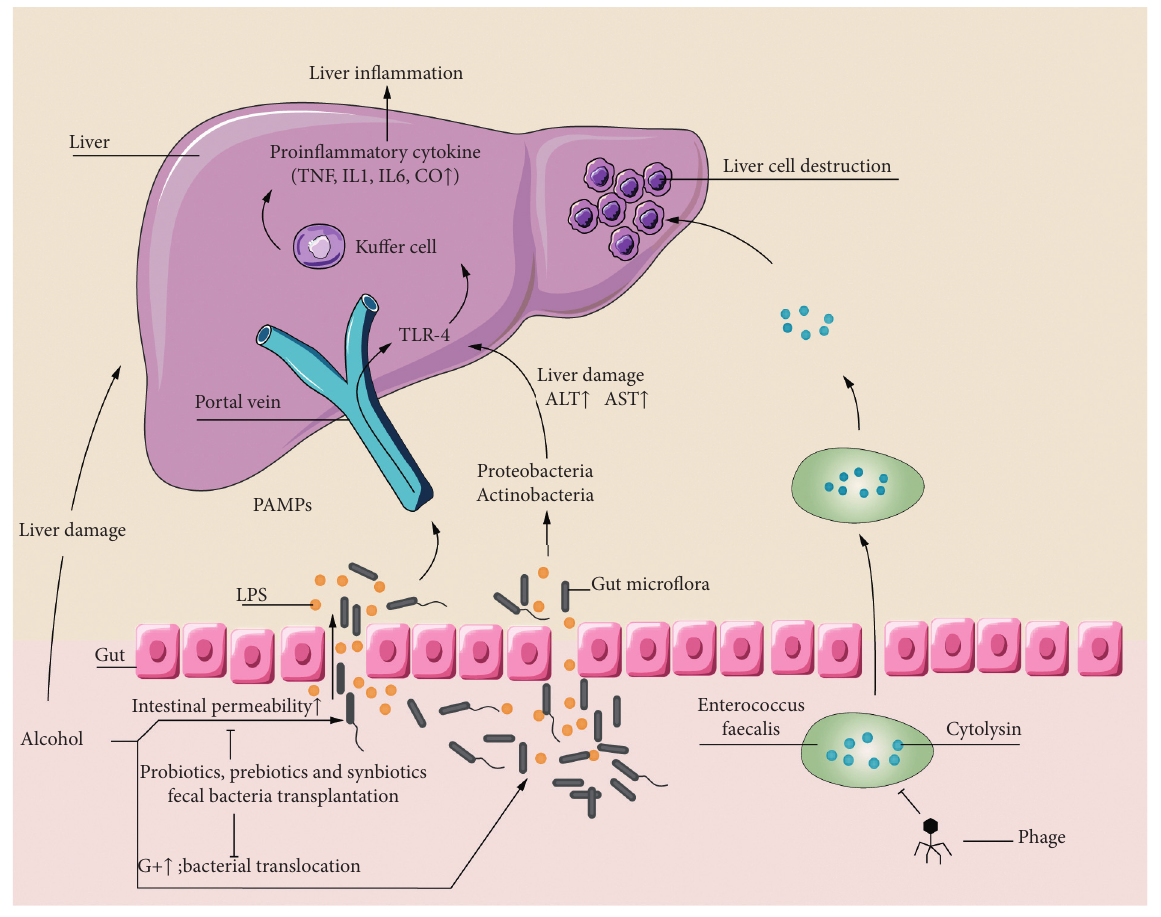
Figure 1: Mechanism of interaction between alcohol-related liver disease and intestinal microbiota. In alcohol-related liver disease, after long-term exposure to alcohol, the liver is directly damaged by alcohol; the expression of tight junction protein in intestinal epithelial cells decreases, the intestinal permeability increases, and the intestinal barrier function is damaged, accompanied by the higher level of endotoxemia. Intestinal microbiota disorders, intestinal microorganisms, bacterial metabolites, toxins, etc., are transferred from the in- testinal tract to the liver, resulting in liver damage. LPS produced by Enterogenous bacteria binds to TLR-4, mediates the activation of liver Kupffer cells. The activated Kupffer cells release a large number of proinflammatory cytokines, induce liver inflammation. Cytolysin produced by Enterococcus faecalis has a dissolving effect on liver cells. Phages can target Enterococcus faecalis and reduce the liver damage. Probiotics, prebiotics, and fecal bacteria transplantation etc., can improve the liver function of patients with alcohol-related liver disease by regulating intestinal microbiota and improving intestinal mucosal permeability. LPS: lipopolysaccharide; G+: Gram-positive bacteria; TLR- 4: toll-like receptor 4; PBMCs: peripheral blood mononuclear cells; IL-1: interleukin-1; TNF: tumor necrosis factor; PAMP: pathogen- associated molecular pattern; CO: carbon monoxide; ALT: alanine transaminase; AST: aspartate